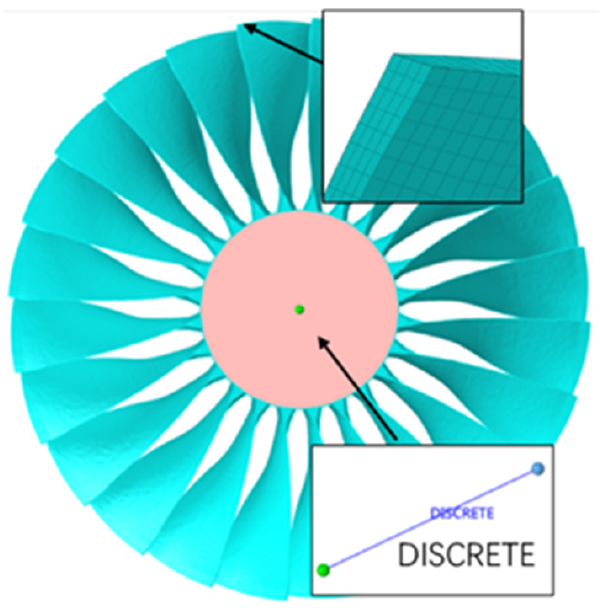
Figure 2. The FE fan model with bearing used in numerical simulation.